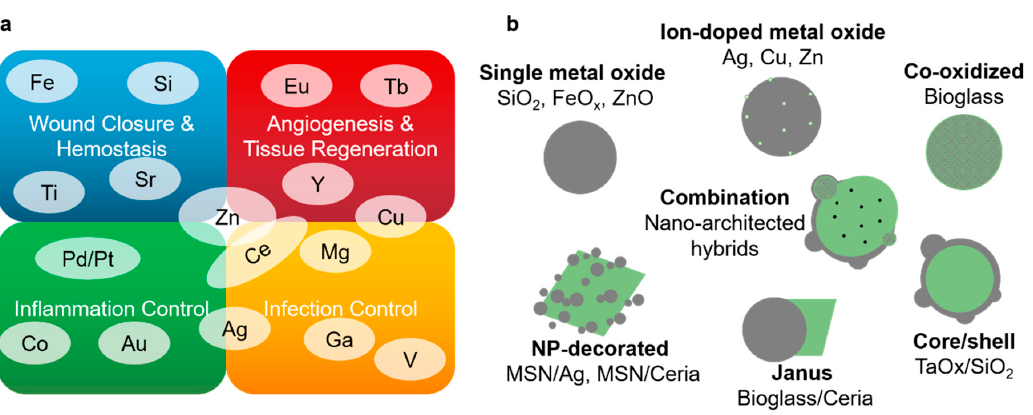
Figure 4. ( a ) Overview of the use of metal oxides in nanoparticulate form for wound healing related processes [59,60,72–76]. ( b ) Different possible architectures and structures of metal oxide